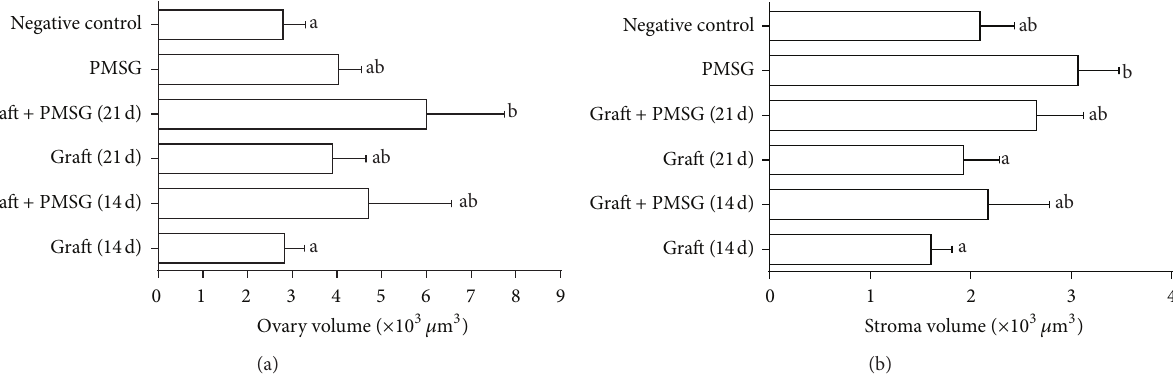
Figure 6: Mean and standard error of histomorphometric analysis of (a) ovarian volume and (b) stroma volume in control group, pregnant mare serum gonadotropin (PMSG) group, transplantation (14 and 21d), and PMSG/transplantation (14 and 21d) groups after autologous ovarian transplantation and superovulatory effect of PMSG. a , b Different superscript letters show significant difference between different groups ( 𝑃 < 0.05